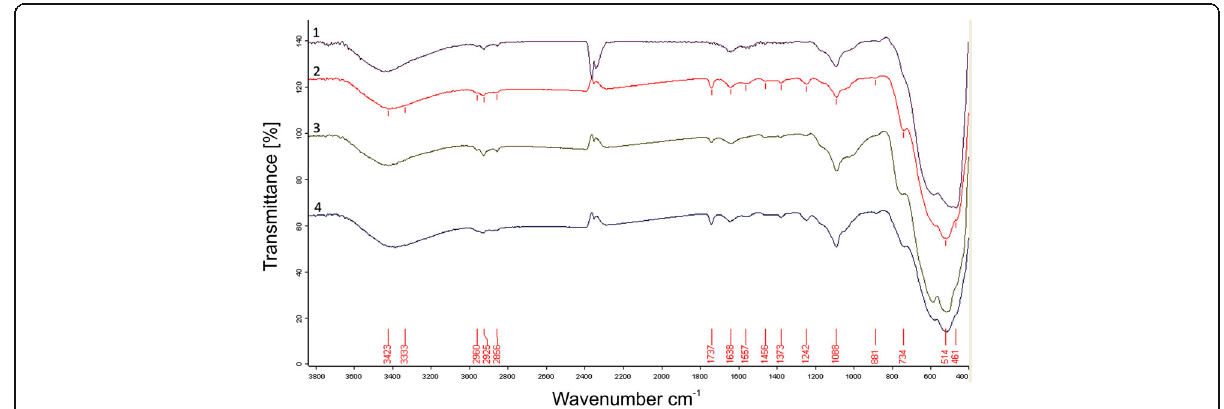
Fig. 2 The FTIR spectra of nanopowders: 1- 3Y-TZP; 2 - PM8-3Y-TZP; 3- PMM8-3Y-TZP-0.2 wt% SiO 2 ; 4- 3Y-TZP-0.2 wt% SiO